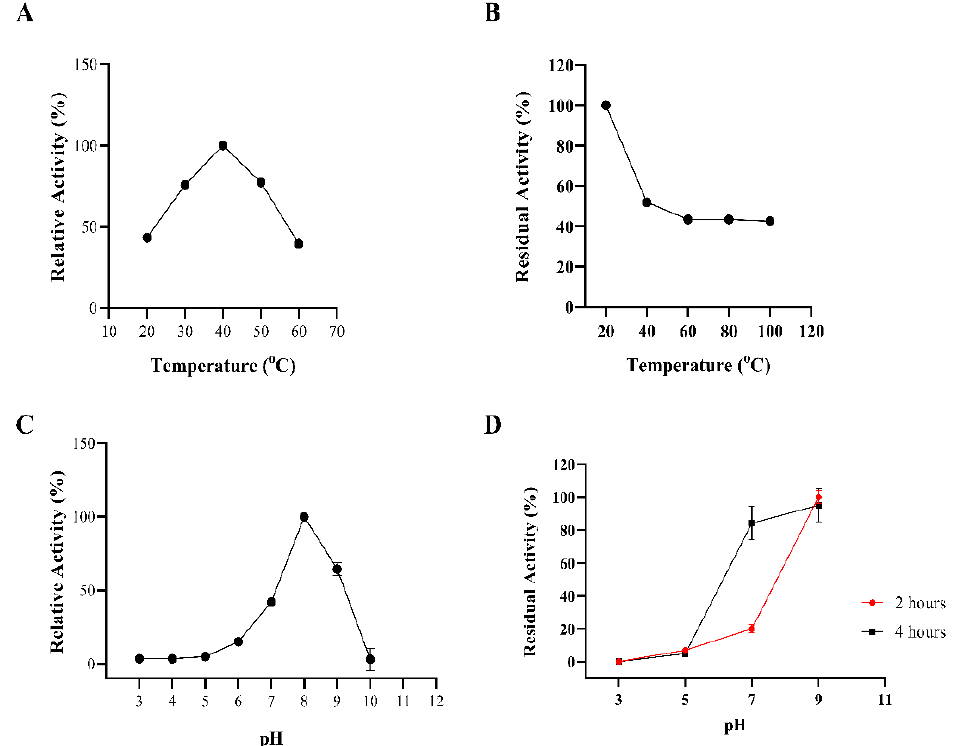
Figure 5. Biochemical properties. The biochemical properties of BaAXE were determined in assays with 4-NPA. ( A ) The optimal temperature was determined in assays performed at different temperatures: 20 °C, 30 °C, 40 °C, 50 °C, and 60 °C. ( B ) Thermostability assay determined after incubating the enzyme for 2 h at different temperatures. ( C ) The optimal pH was determined in assays performed at different pHs at the optimal temperature. ( D ) pH stability was determined after incubation of the enzyme for 4 h at 20 °C. After 2 h of incubation, residual activity was determined, and after 4 h, the residual activity was determined. Absorbance readings were measured at 410 nm. Assay without the enzyme was used as blank. Assays were performed in triplicate, and error bars correspond to SEM.